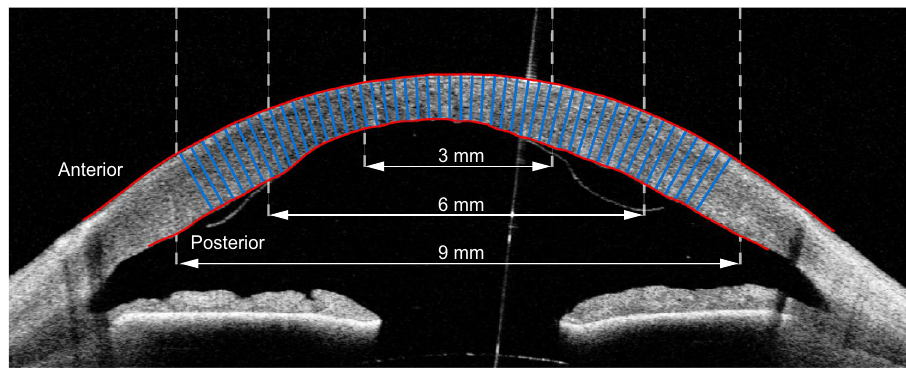
Figure 1. Single image (B-scan) from an AS-OCT scan, showing the cornea and the anterior chamber. This B-scan was cropped centrally and horizontally aligned as reported by Heslinga and Alberti 14 . Manual delineations of the corneal interfaces are shown in red. Corneal thickness is measured as the distance between the anterior and posterior interface, perpendicular to the anterior interface. The blue lines illustrate a subset of these thickness measurements. For evaluation of the thickness measurements, we distinguish the central 3 mm, 6 mm, and 9 mm diameter with respect to the corneal apex.